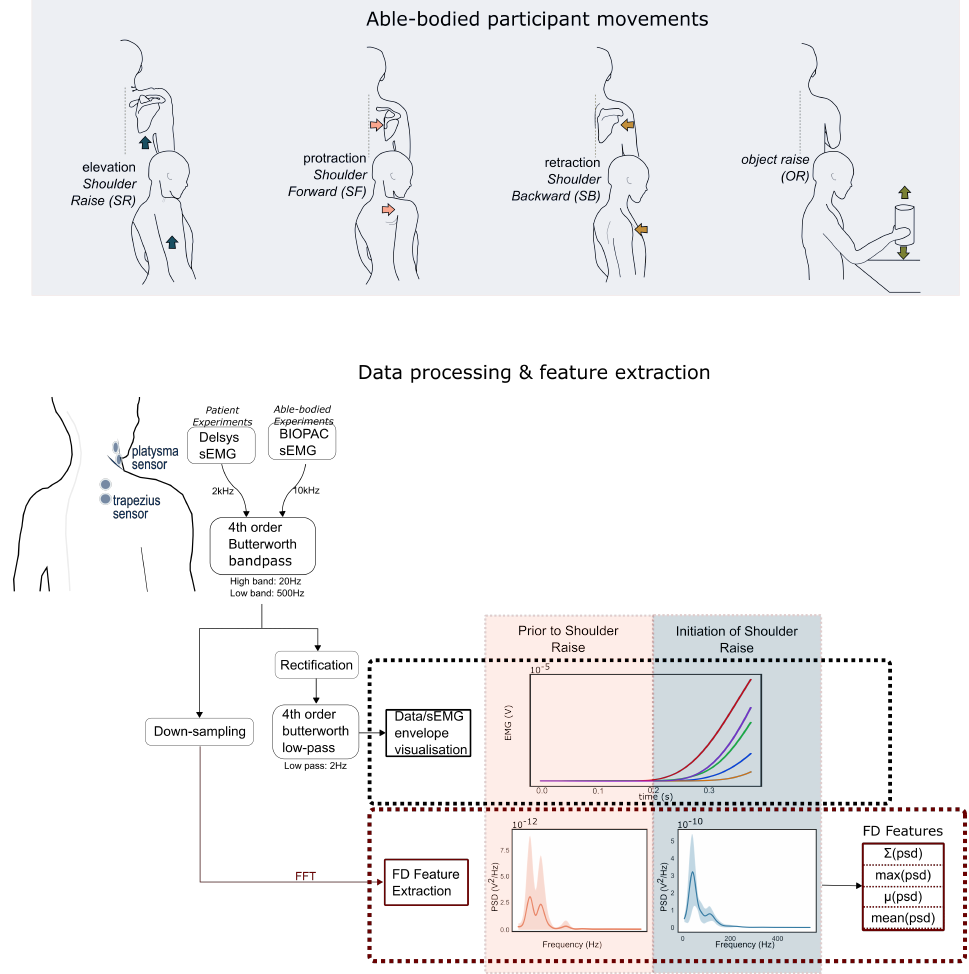
Figure 1. ( Top ): The movements attempted by the able-bodied participants in Protocol A (Section 2.1). ( Bottom ): The flow diagram demonstrates the processing of the data leading to the extraction of the frequency domain data and visualisation of the signal’s envelope. Five instances of shoulder raise are presented in the time and frequency domains, before and after the action. In the frequency domain plots, the bold lines present the mean PSD and the shaded regions the standard